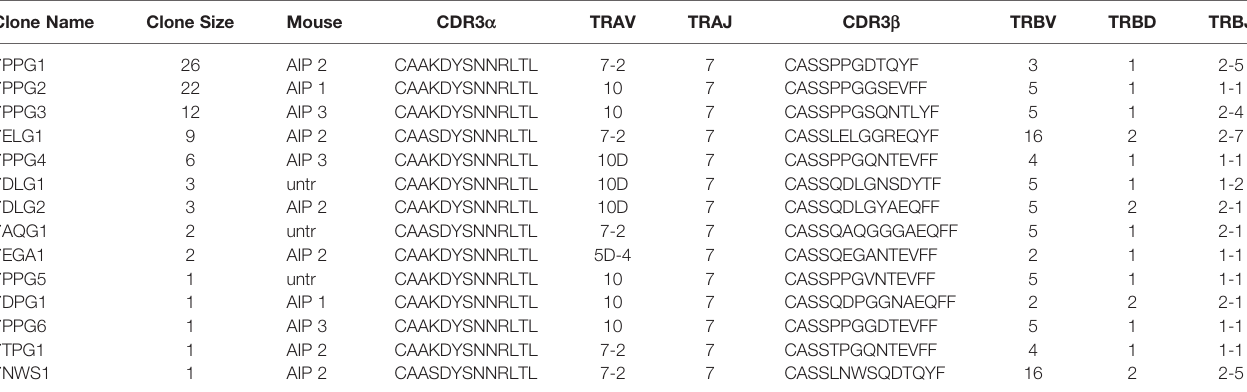
TABLE 1 | CDR3 sequences and gene usage for T cells with strikingly similar TCR sequences. Clone Name